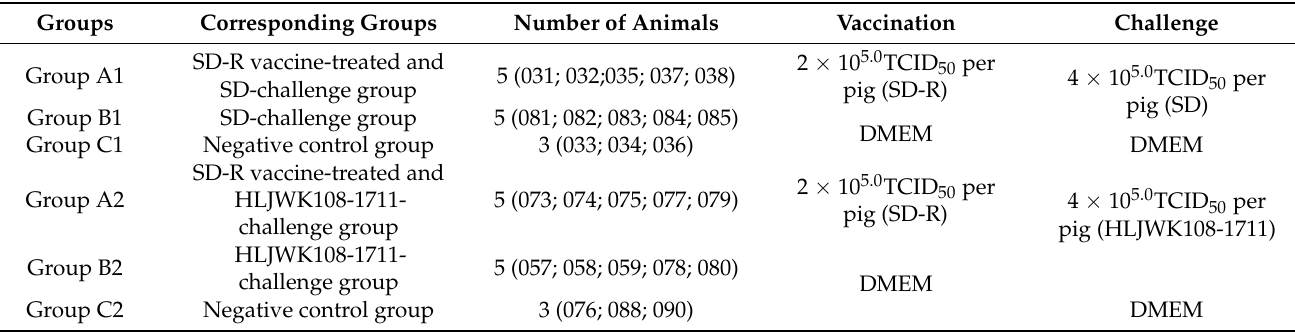
Table 2. Group information for effectiveness evaluation of SD-R. Corresponding Groups Number of Animals